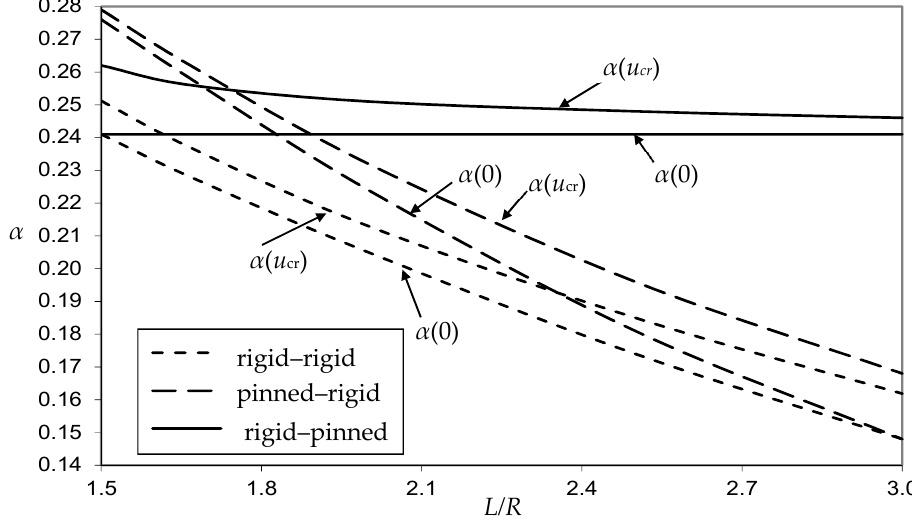
Figure 3. The dependence of α (0) and α ( u cr ) on L / R for various connection schemes. The expression for y ( x ) in these equations is a particular solution of Equation (7) corre- sponding to the boundary conditions combination at the rod ends. For all connection types, the transverse stiffness can be represented as K = K (cid:48) EI / L 3 , where K (cid:48) is non-dimensional stiffness: for the rigid–rigid connection